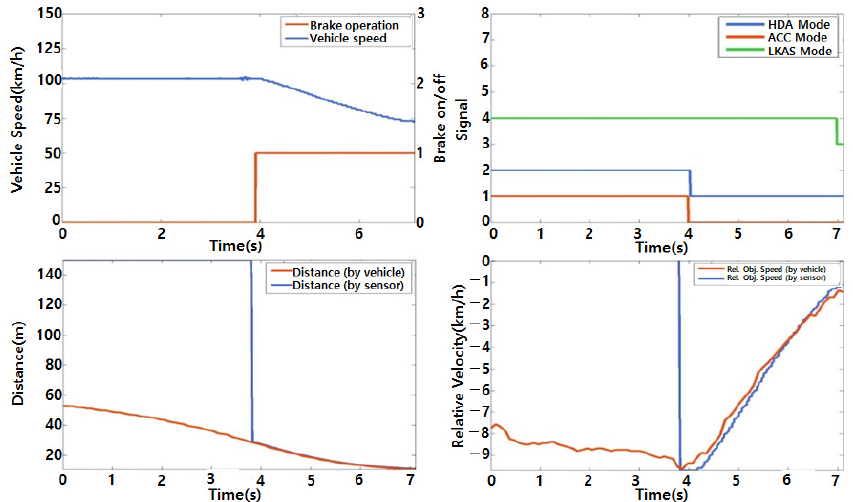
Figure 5. Preliminary data analysis for case 2.